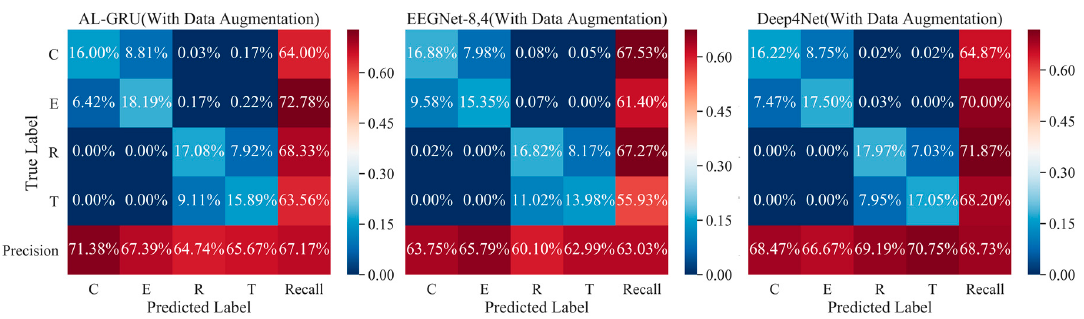
Figure 8. Confusion matrices of different models with data augmentation by randomly averaging.